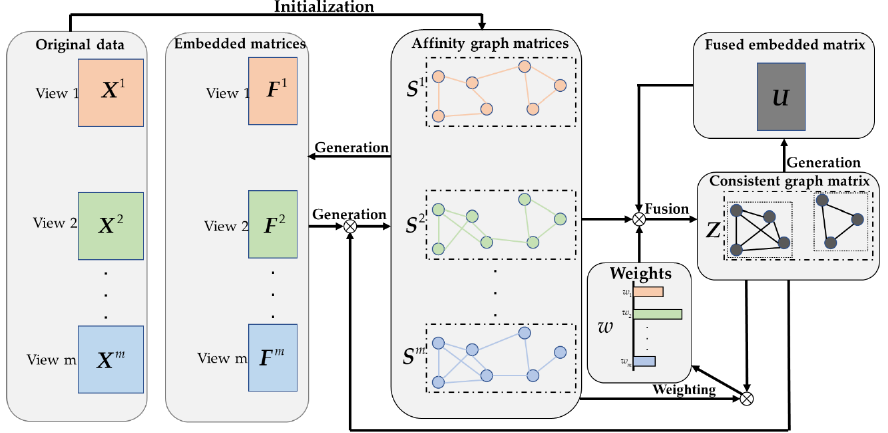
Figure 1. The flow chart of Laplacian Rank Constrained Multiview Clustering.